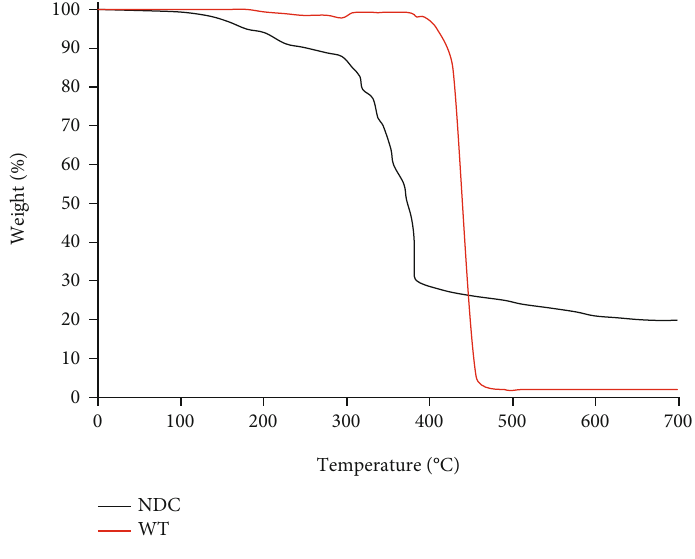
Figure 2: TGA thermogram of NOC and WT.